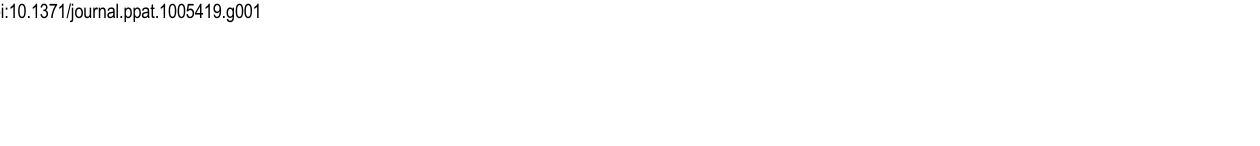
PLOS Pathogens | DOI:10.1371/journal.ppat.1005419 February 4,